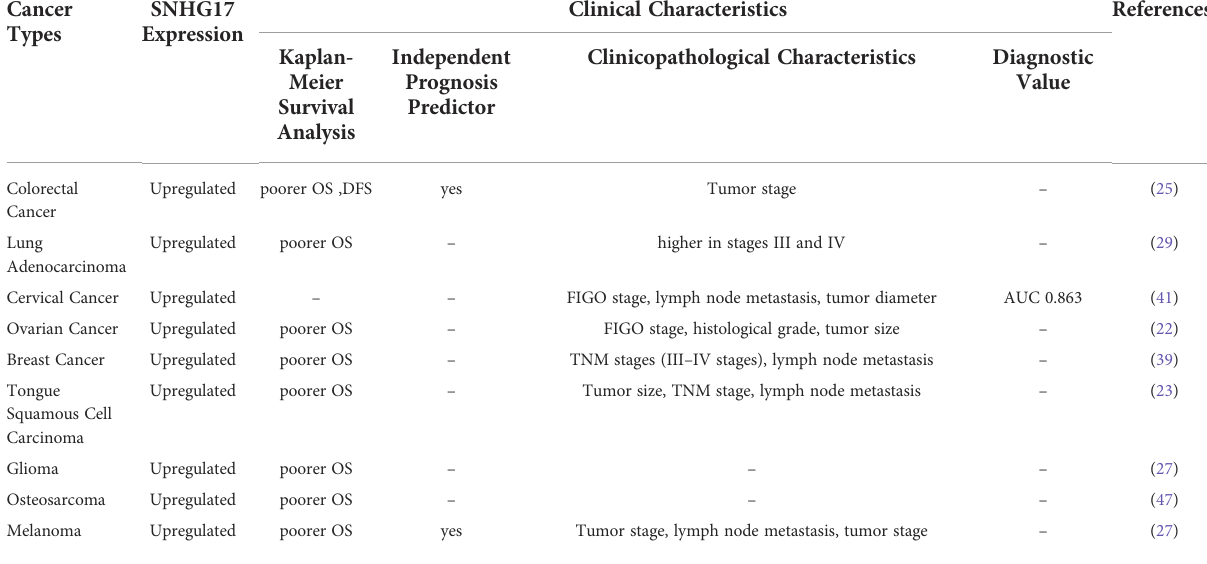
FIGO stage, lymph node metastasis, tumor diameter FIGO stage, histological grade, tumor size